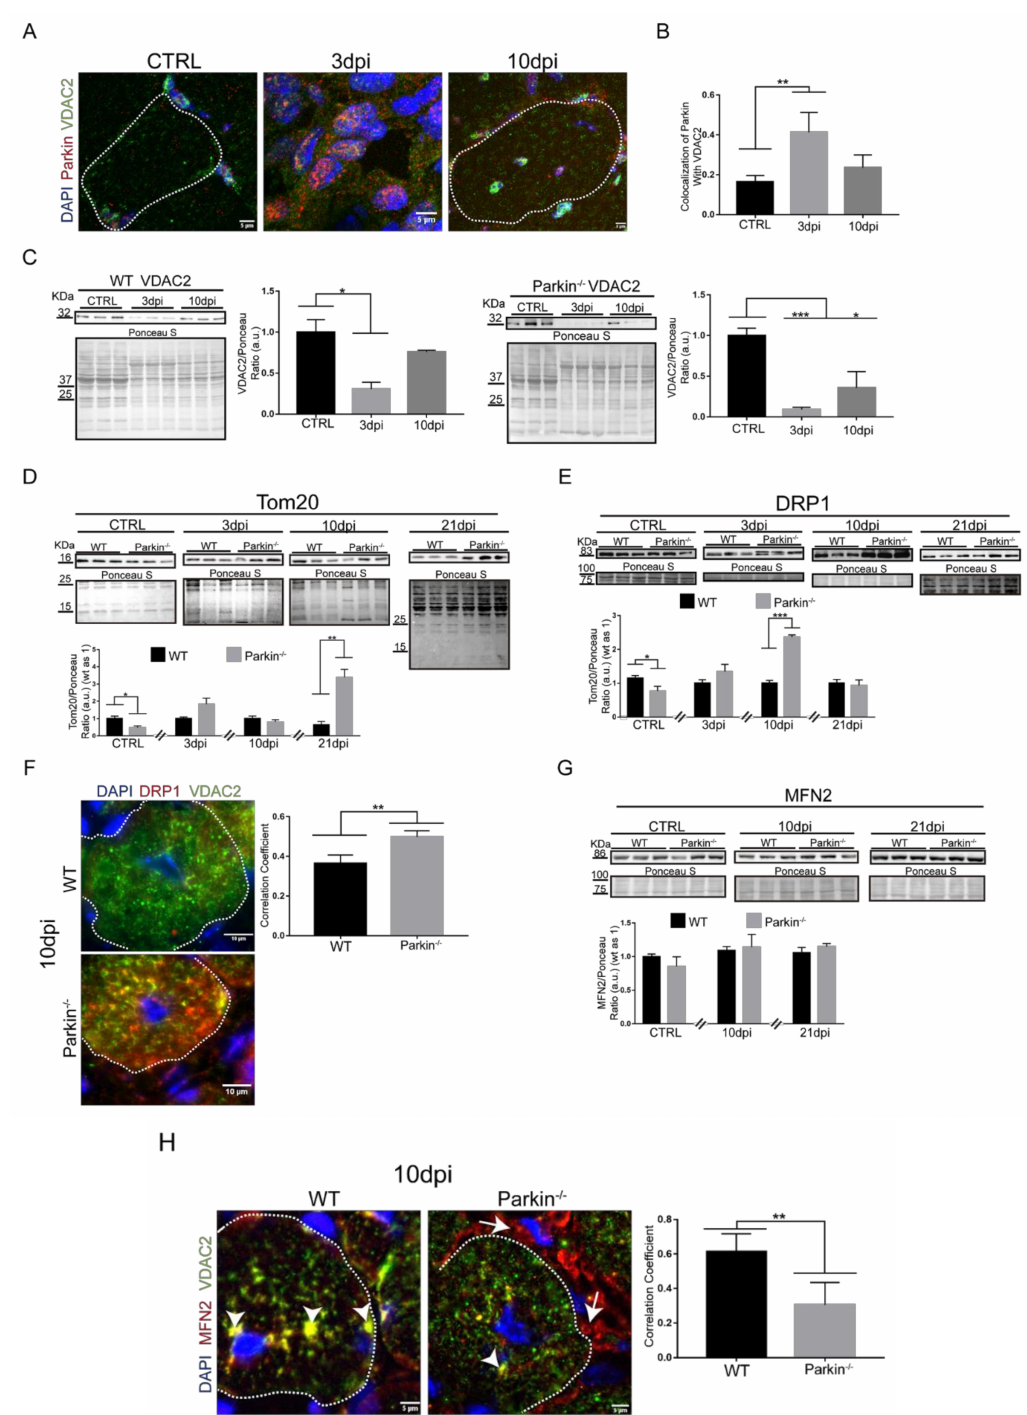
Figure 6. Parkin − / − mice shows altered mitochondrial dynamics during skeletal muscle regeneration. ( A ) Immunofluorescence confocal images of Parkin (red), VDAC2 (green), and DAPI (blue) in TA muscle cryosections from in CTRL and 3 and 10dpi WT mice. The myofibers are labeled by dotted area. The images were acquired with a 63 × objective. Bars represent 5 µ m. ( B ) Colocalization of Parkin with VDAC2. Data represent means ± SD ( t -test: ** p < 0.01; n = 5). ( C ) Western blot and densitometry analysis of VDAC2 levels during the regenerative process in CTRL, 3dpi and 10dpi TA muscle from WT and Parkin − / − mice. Comparisons were made with the TA muscle in CTRL of each genotype. Ponceau S staining was used to normalize for loading. Data represent means ± SEM (One-way ANOVA: * p < 0.05; *** p < 0.001; n = 5). ( D ) Western blot and densitometry analysis of Tom20 levels during the